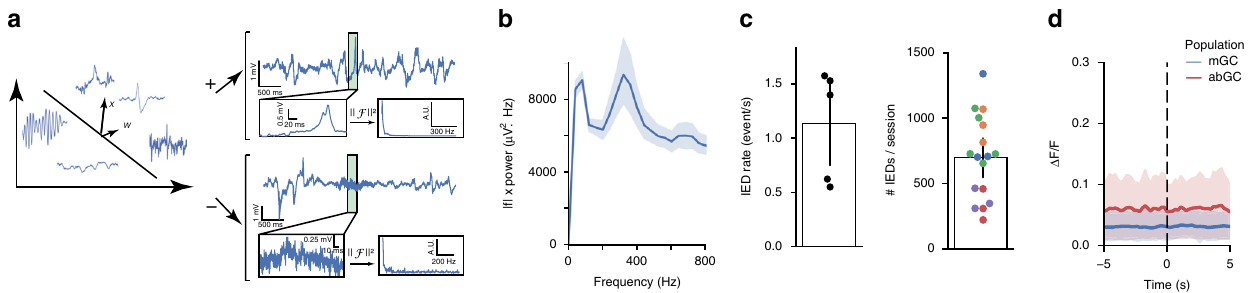
Fig. 2 Interictal spike identi fi cation and basic characterization. a Classi fi er schematic. Left: An Online Kernelized Perceptron was trained on the LFP magnitude spectrum where the window size was locked to each imaging frame. Right: Examples of classi fi ed interictal spike (above) and non-spike (below) highlighted in green, with expanded view (below left) and magnitude spectrum (below right). b Average IED magnitude spectrum. Average magnitude spectrum of n = 459 events from one subject, with 1/ f power correction applied (data presented as mean value + / − 95% CI). A peak frequency occurs in the 250 – 400 Hz range, exaggerated by the 1/ f correction, re fl ecting the timescale of positive and negative de fl ections (on the order of 10 ms in an event lasting ~50 ms), which may be polyphasic for some IEDs. c Summary of detected IEDs rate across mice ( n = 5 mice). Left: Average IED rate, mean 1.13 IED/ s, standard deviation 0.53 IED/s. Each point corresponds to a mouse (average of 3 – 5 sessions per mouse). Right: Total IED count per 10-min recording session, mean count = 680 IEDs/session, standard deviation = 319 IEDs/session (each point corresponds to a single session, each color corresponds to a different mouse). Error bars: + / − 95% CI in the mean, calculated from 1000× bootstrap sampling on recording sessions with replacement. d Spike- triggered PSTHs showing averaged response to IED by cell type, pooled across fi ve animals ( n = 239 abGCs, red; 1736 mGCs blue). The majority of GCs are not modulated by individual spikes on average (data presented as mean value + / − 95%